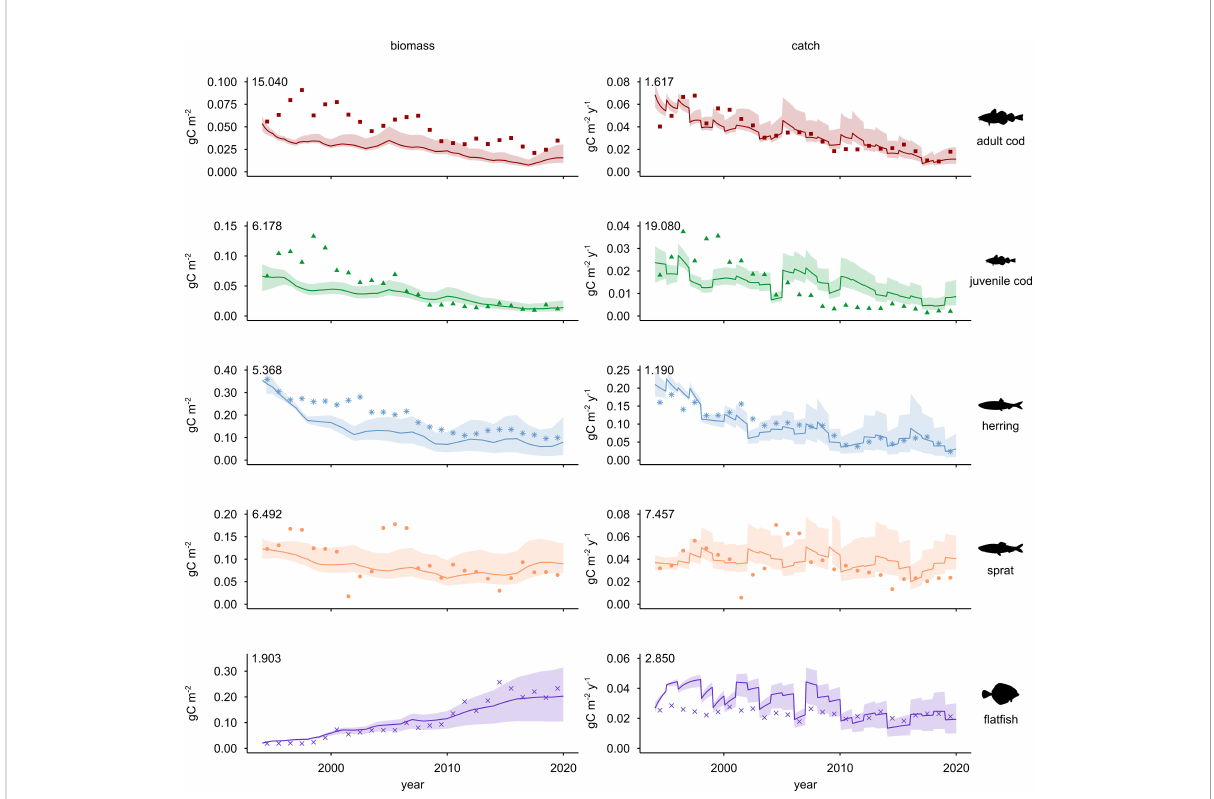
FIGURE 3 Comparison between observed data and Ecosim predictions for trends of biomass (left) and catch (right). Results refer to commercially most relevant fi sh stocks, from 1994 until 2019. Fishing mortality (F) is the forcing factor used to perform simulations. Plots show changes for adult cod, juvenile cod, herring, sprat, and fl at fi sh. The match between model predictions (continuous line) and observed time series (dots) is visualized. Shaded areas illustrate non-parametric con fi dence intervals (2% and 98%). Numbers in the upper left corner of plots represent the sum of squares (SS) of residuals between predictions and observations, as a measure of goodness of fi